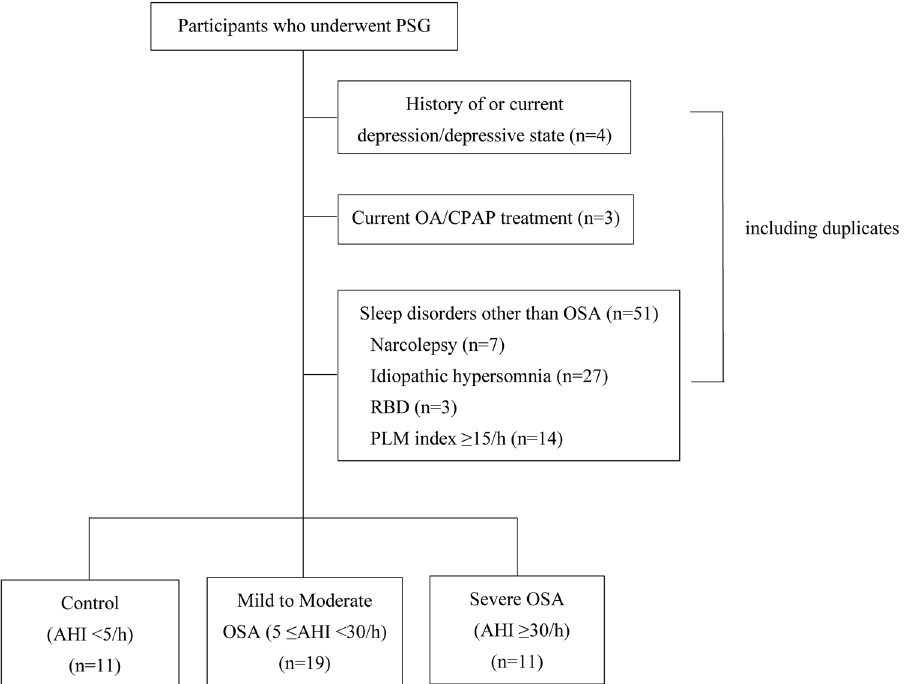
Figure 3. Flow diagram of this study. AHI, apnea-hypopnea index; CPAP, continuous positive airway pressure; OA, oral appliance; OSA, obstructive sleep apnea; PLM, periodic limb movement; PSG, polysomnography; RBD, rapid eye movement sleep behavior disorder.